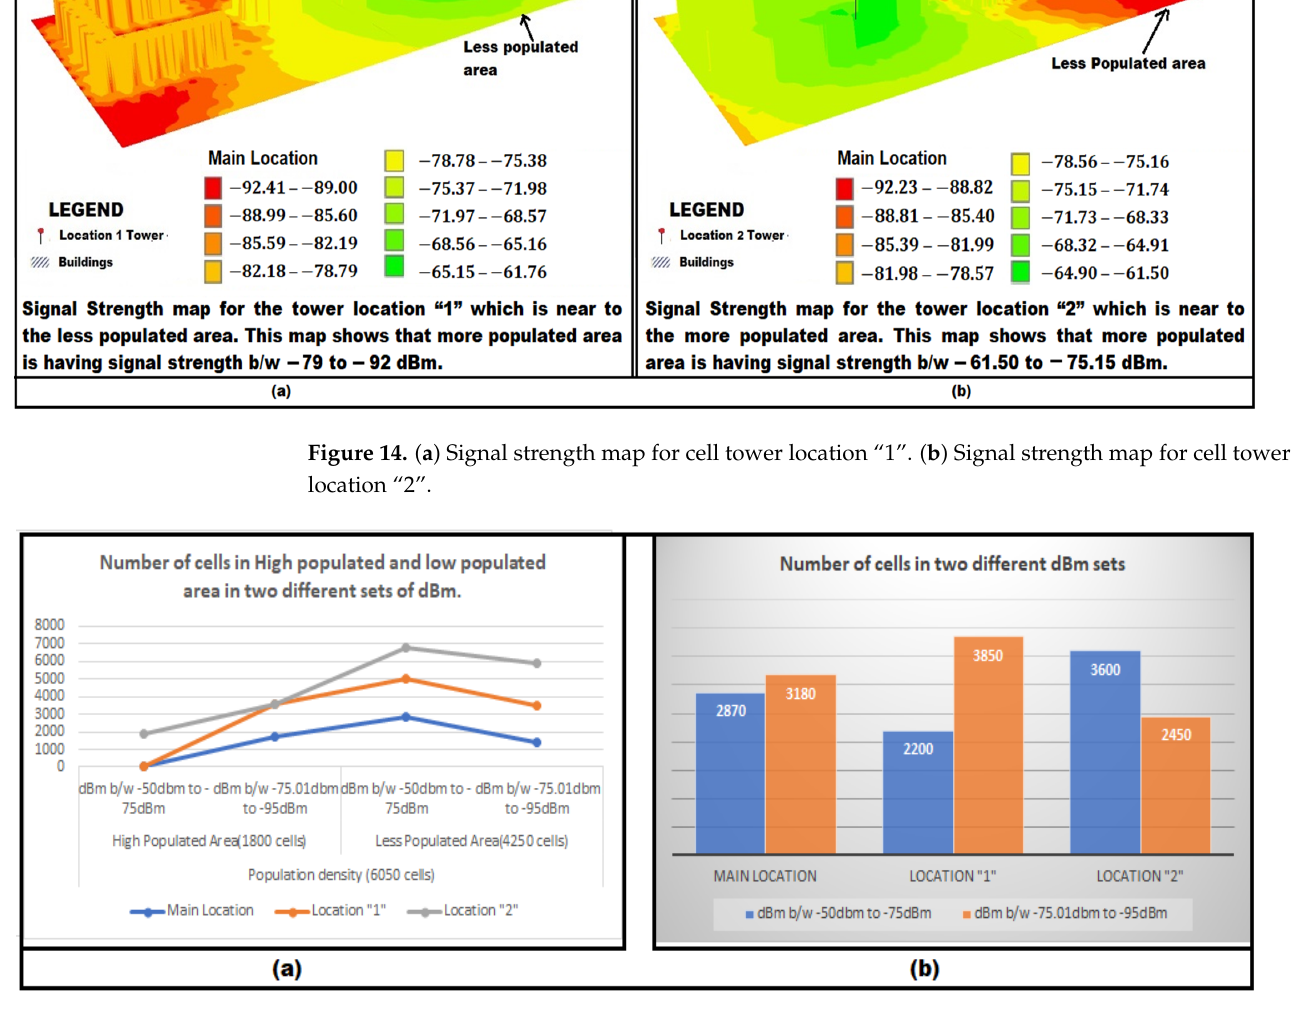
Figure 15. ( a ) Number of cells between the high and low-populated areas according to the two dB m sets for the three locations of the tower. ( b ) Number of cells for the whole area for the three locations of the tower. Table 1. Percentage change in locations “1” and ”2” from cell values of the main location.